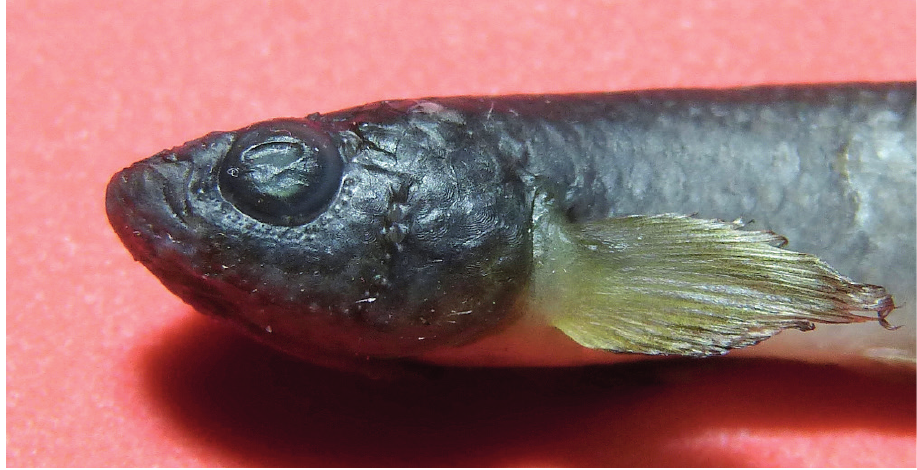
FIGURE 5 | Moema juanderibaensis , MNKP 16541, paratype, male, 46.1 mm SL, Bolivia, Santa Cruz, Santa Rosa del Sara. Detail of infraorbital, preopercular and mandibular neuromast